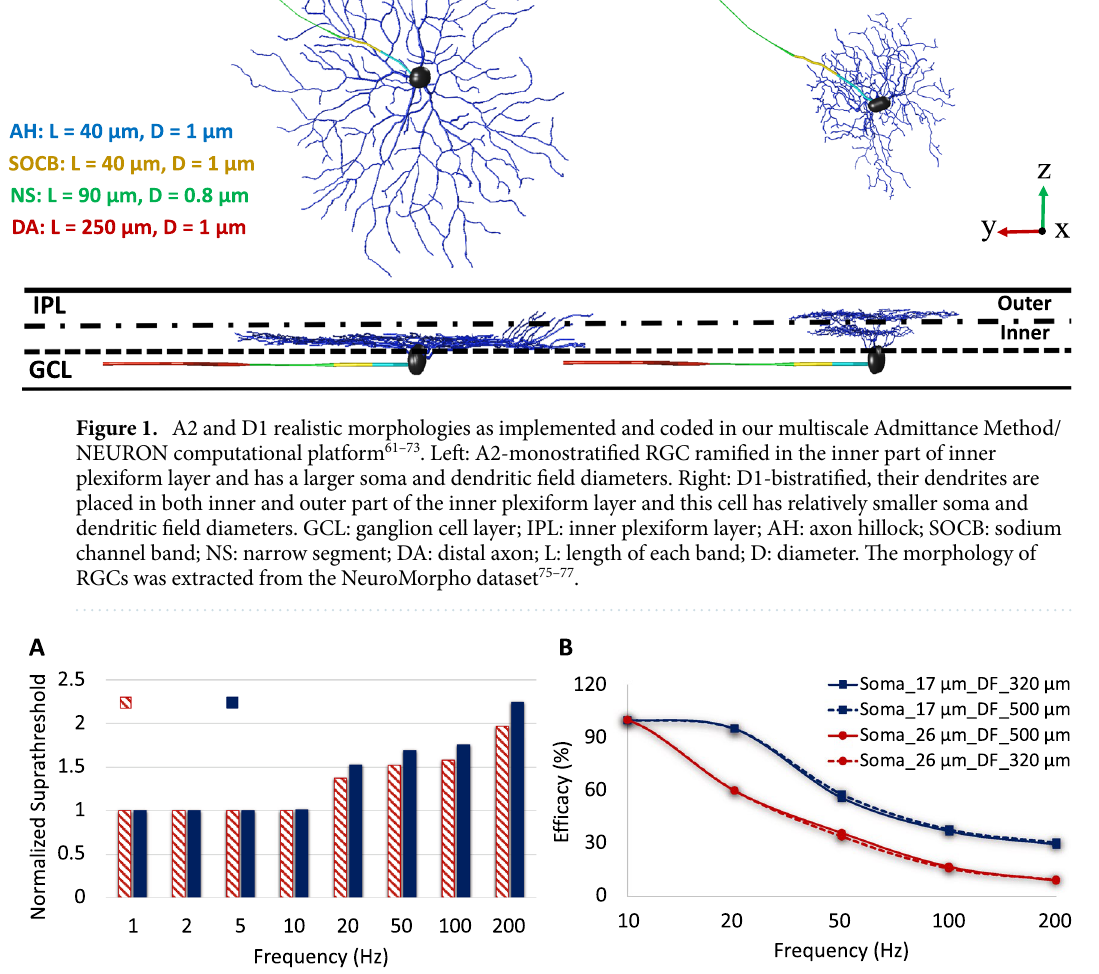
Figure 6. The model verification with in-vitro experimental results from 8 . ( A ) Suprathreshold current required to reach at least 90% efficacy as alterations in stimulus frequency for both small and large A2-cells using an asymmetric cathodic-first stimulus waveform (normalized to 1 Hz). The solid and shaded bars demonstrate the normalized stimulus threshold of large and small cells, respectively. The figure clearly shows the greatest stimulus threshold difference between small and large cells at high frequency. ( B ) Impacts of soma and dendritic field sizes on efficacy for a given pulse amplitude (435 µA cathodic phase amplitude). Small cells are able to maintain their response at higher efficacy compared to large